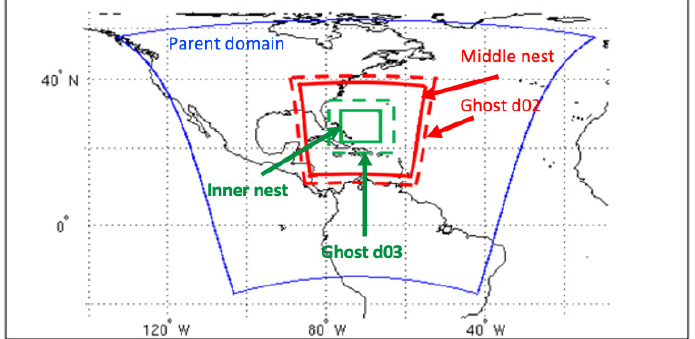
Figure 1. Domain coverage for HWRF data assimilation and forecasts. The parent domain is 77.2° by 77.2° with its center determined based on the initial location of the storm’s position and the 72-h forecast from NHC or the JTWC. The two nested domains are 17.8° by 17.8° and 5.9° by 5.9°. Resolution of outer, middle, and inner domains are 13.5 km, 4.5 km, and 1.5 km, respectively. Data assimilation is applied to ghost d02 and d03 and they have the same spatial resolution as the nested domains. They have larger domain coverage (28° by 28° and 15° by 15°).